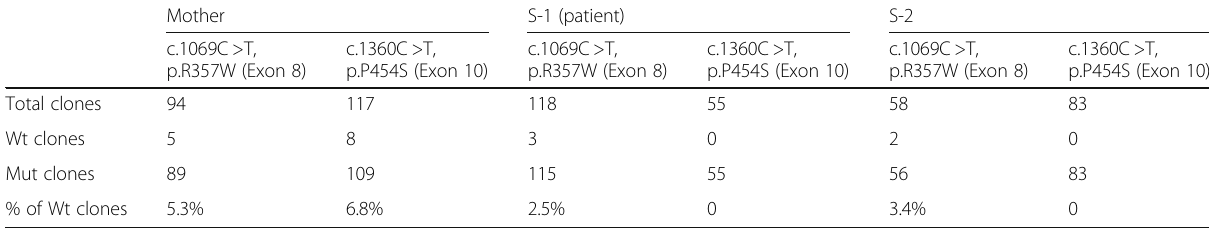
Table 4 Quantification of wild-type and mutant CYP21A2